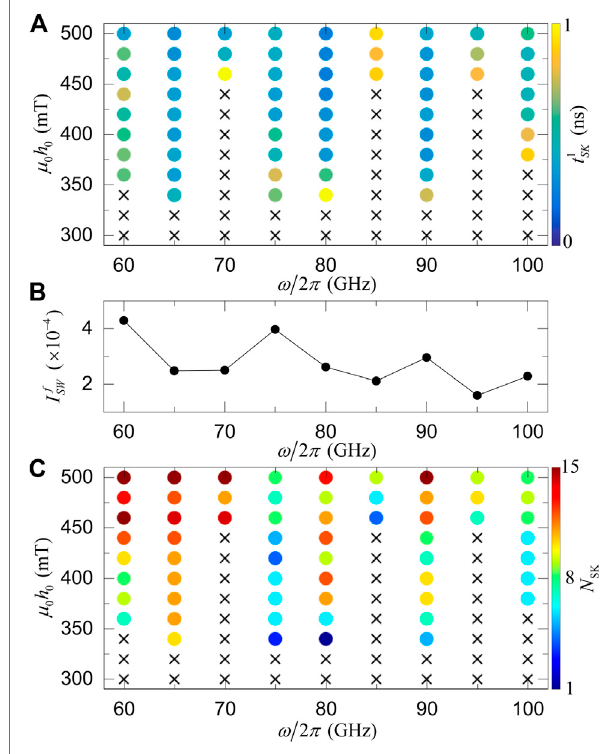
FIGURE4|(A) Thenucleation timeofthe fi rst skyrmion t 1 SK asafunction ofthe fi eldamplitudeandfrequency.Theblackcrossesrepresentnoskyrmion creation. (B) The frequency dependence ofthespin wave intensity at the focal pointunderthemicrowave fi eldwith μ 0 h 0 (cid:2) 10 mT. (C) Phasediagramof skyrmion generation with respect to the amplitude and frequency of the exciting fi eld with the duration time 10 ns.